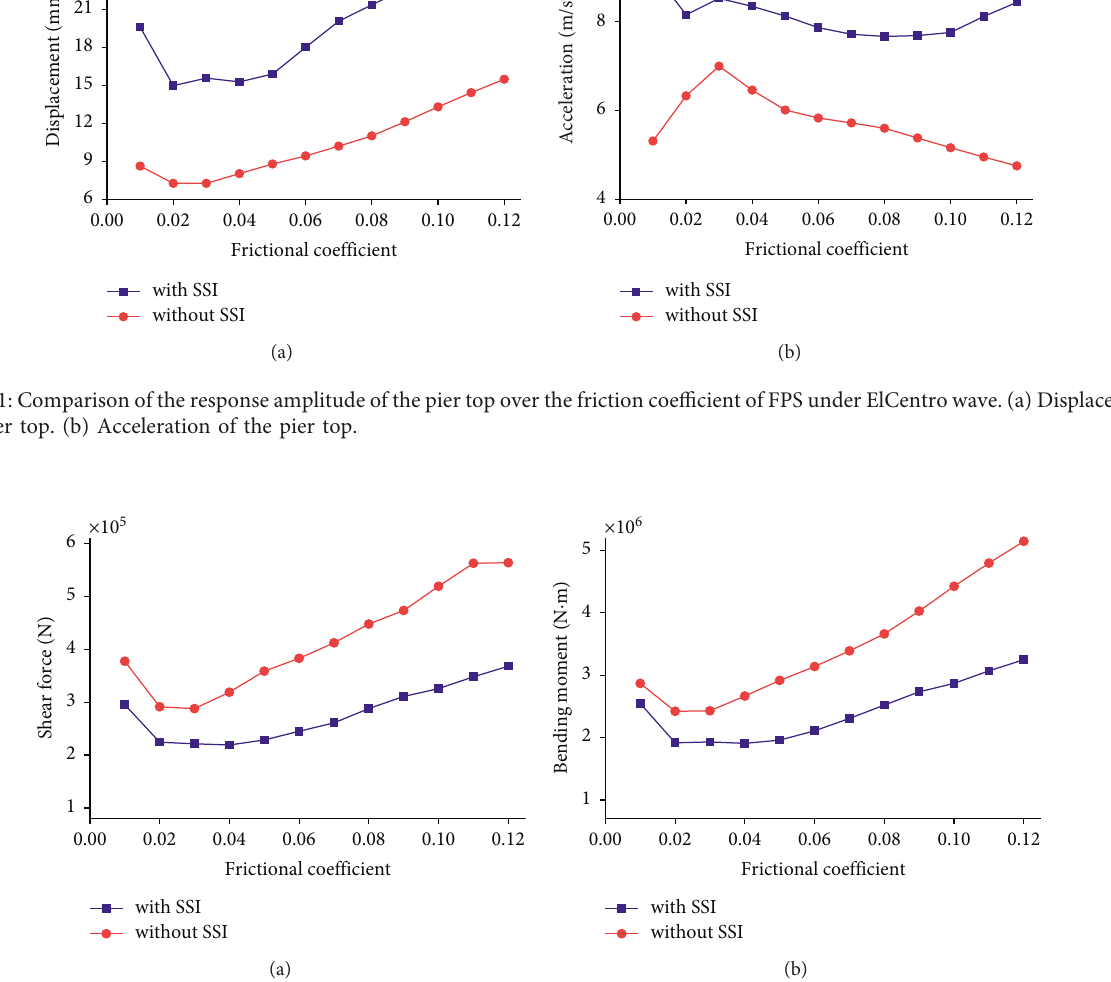
Figure 12: Comparison of the response amplitude of the pier bottom over the friction coefficient of FPS under ElCentro wave. (a) Shear force of the pier bottom. (b) Bending moment of the pier